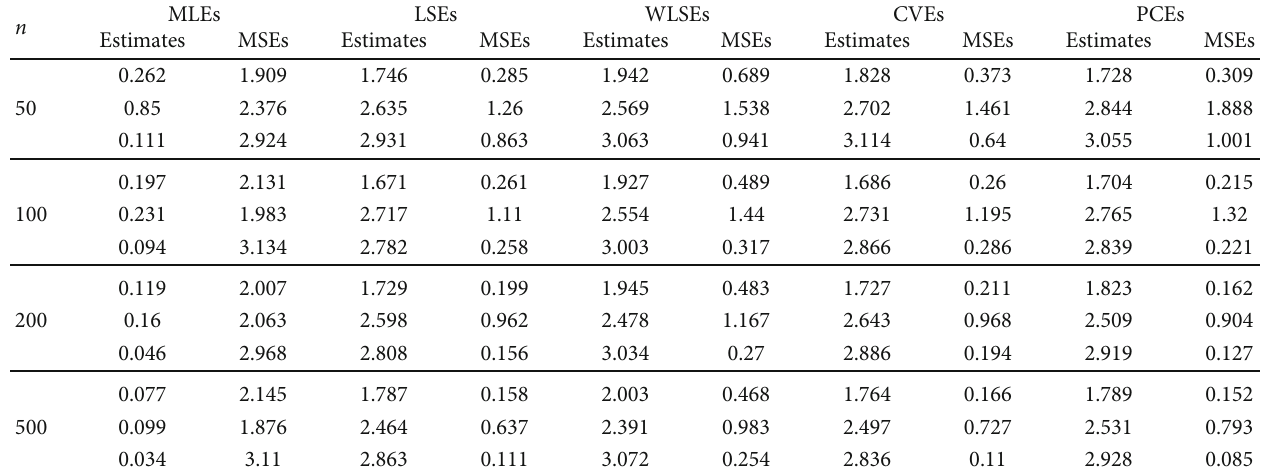
Table 4: Estimates and MSEs of parameters of TIIHLKwD for the Set3 ( a = 2, λ = 2, b = 3